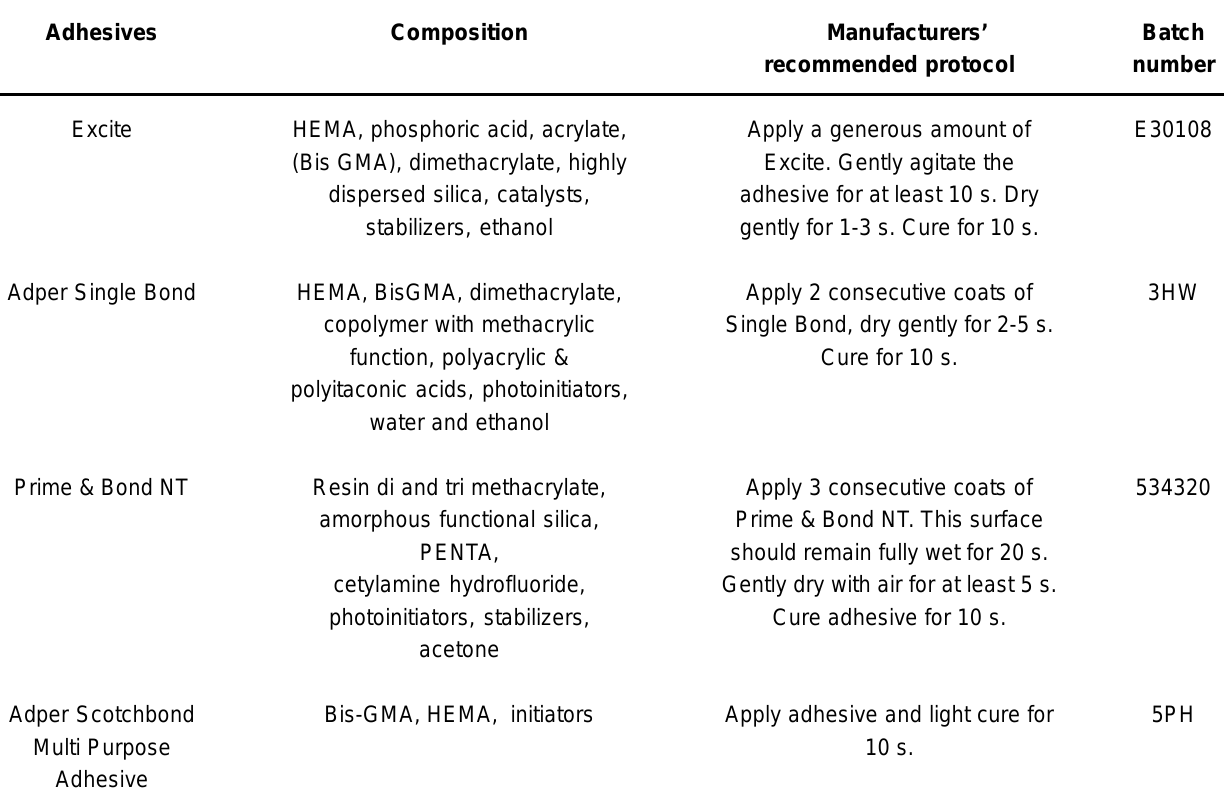
TABLE 1- Composition, manufacturers’ instructions and batch number of the adhesives used in this